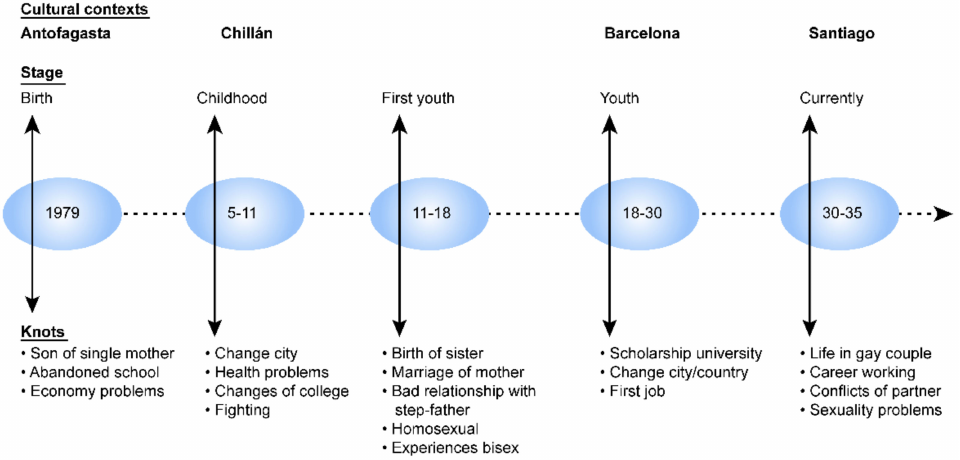
Figure 2. Example of the preparation of a lifeline, as instructed in courses and